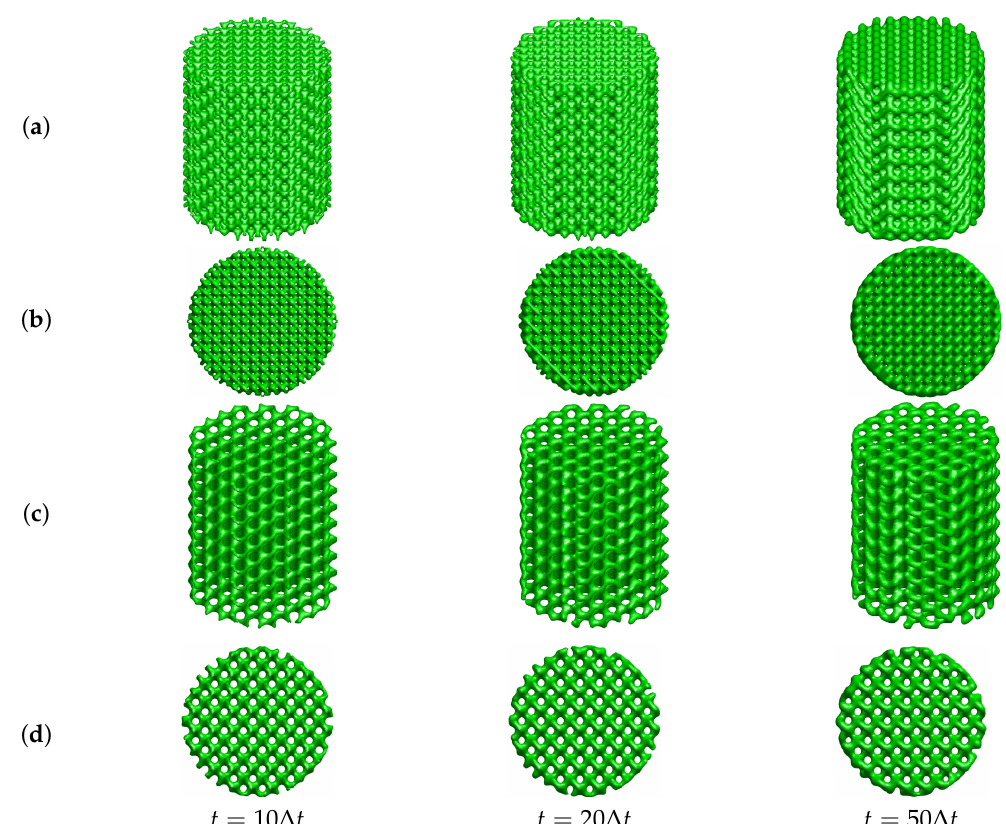
Figure 17. Cylindrical scaffolds using the ( a , b ) D and ( c , d ) G surfaces. Snapshots of phase separation at t = 10 ∆ t , 20 ∆ t , and 50 ∆ t from left to right.